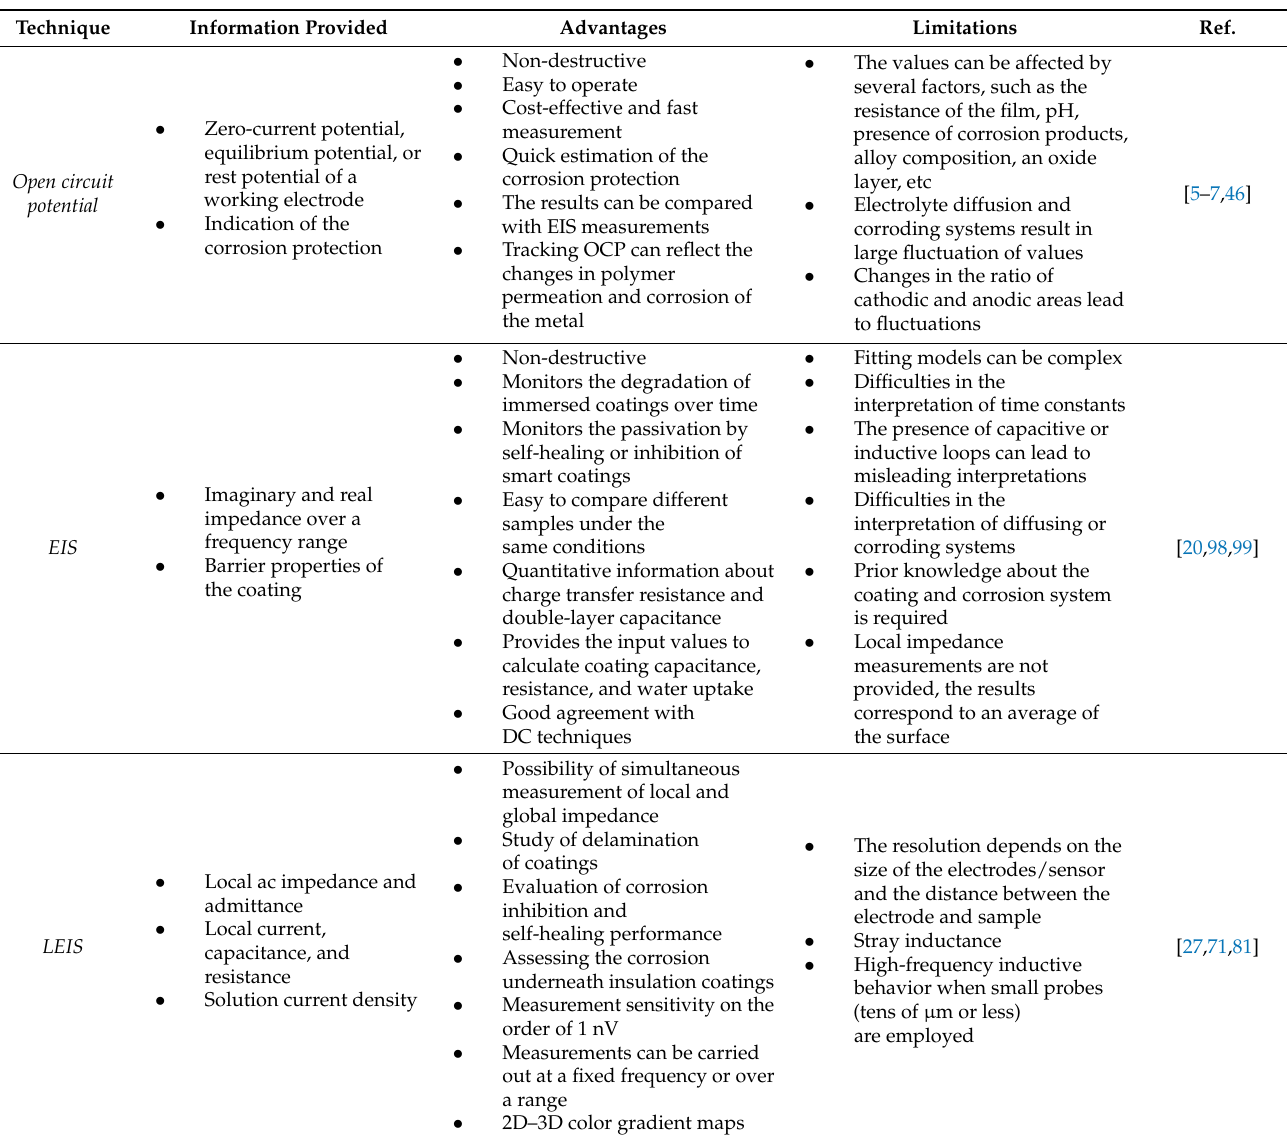
Table 1. Information provided, advantages, and limitations of electrochemical techniques used for the characterization of polymeric